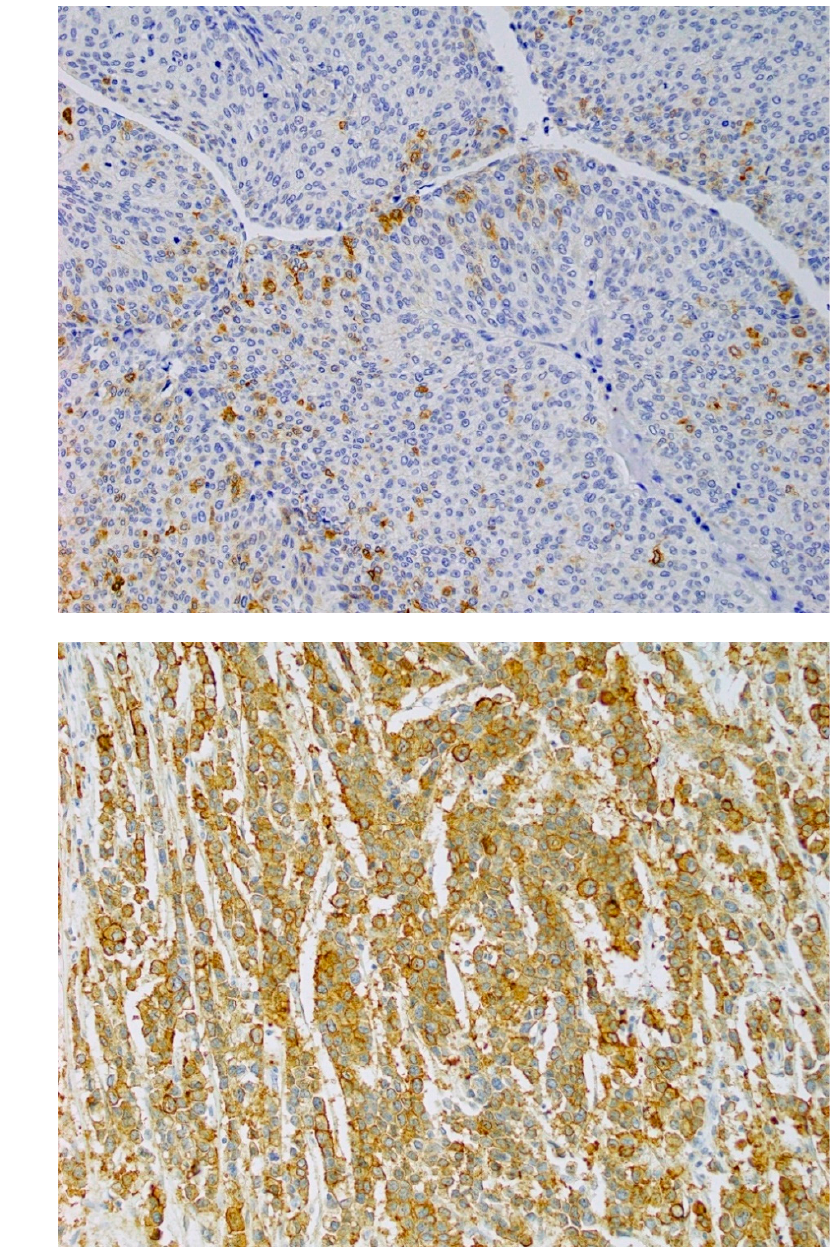
Figure 1. Immunohistochemical analysis of AHNAK2 expression in normal urothelial and bladder carcinoma tissues. Microscopic images are representative normal urothelial and bladder cancer (BCa) tissues for AHNAK2 staining (200 × magnification). ( A ) AHNAK2-negative normal urothelial tissues. ( B ) AHNAK2-negative BCa tissues: score 0. ( C ) AHNAK2-negative BCa tissues: Score 2. ( D ) AHNAK2-positive BCa tissues: Score 12.